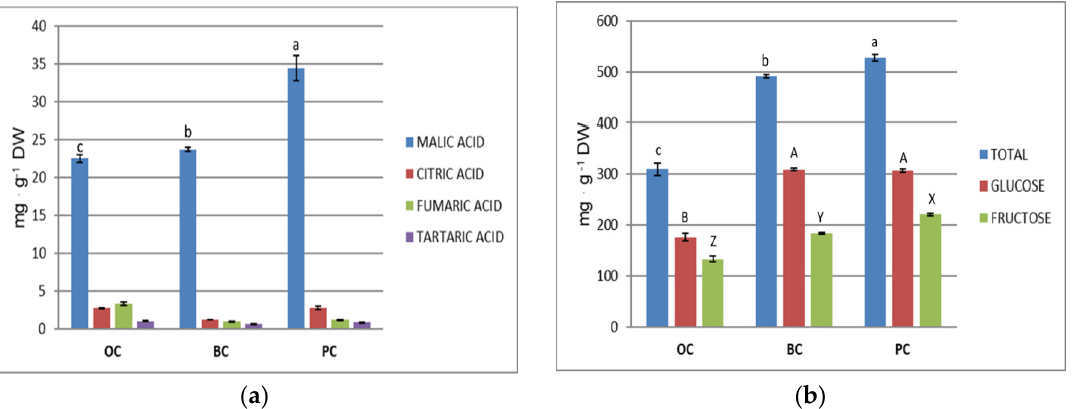
Figure 6. ( a ) Organic acid content (mg. g − 1 DW) and ( b ) glucose and fructose content (and total= glucose + fructose) (mg. g − 1 DW) in orange carrot (OC), black carrot (BC) and purple “Polignano” carrot (PC) extracts. Data are the means ± SDs ( n = 3). Different letters for each parameter indicate statistically significant differences at p ≤ 0.0001.